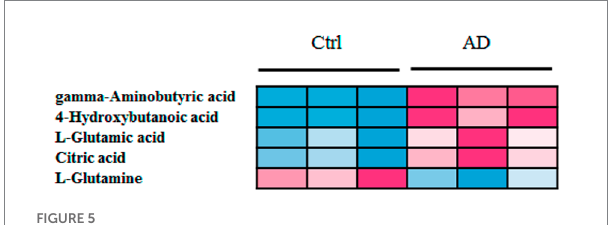
FIGURE 5 Heat map of screened metabolite markers in validation samples. Ctrl: control group; AD: alcohol dependence group.